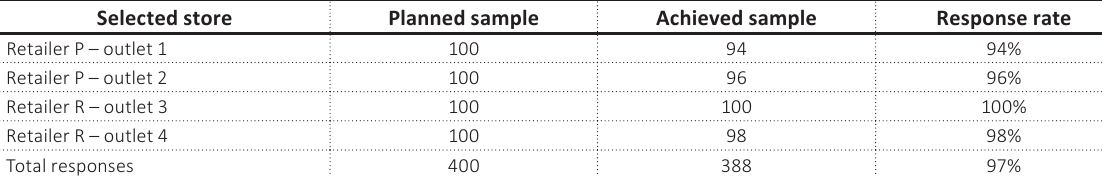
Table 4. Profile of respondents’